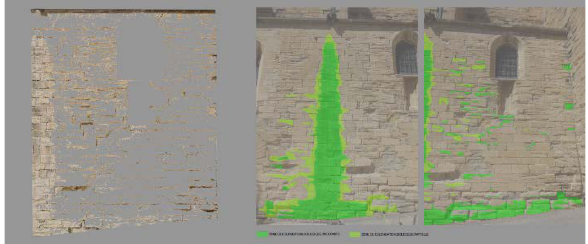
Figure 24. Comparison between traditional and digital cartography: selection by RGB value.